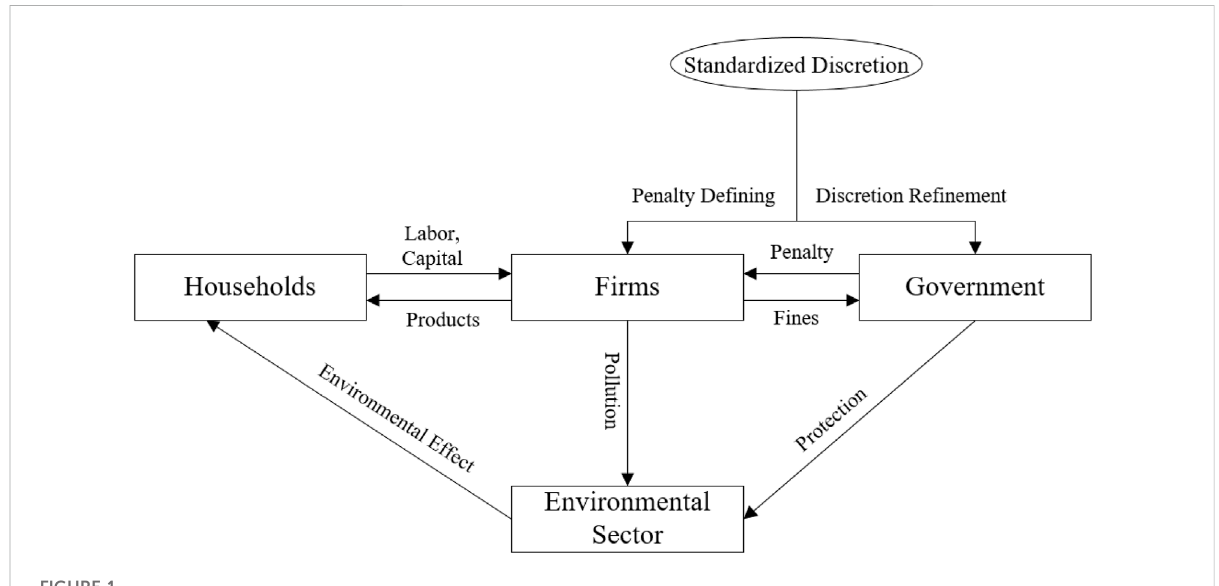
FIGURE 1 Mechanism of